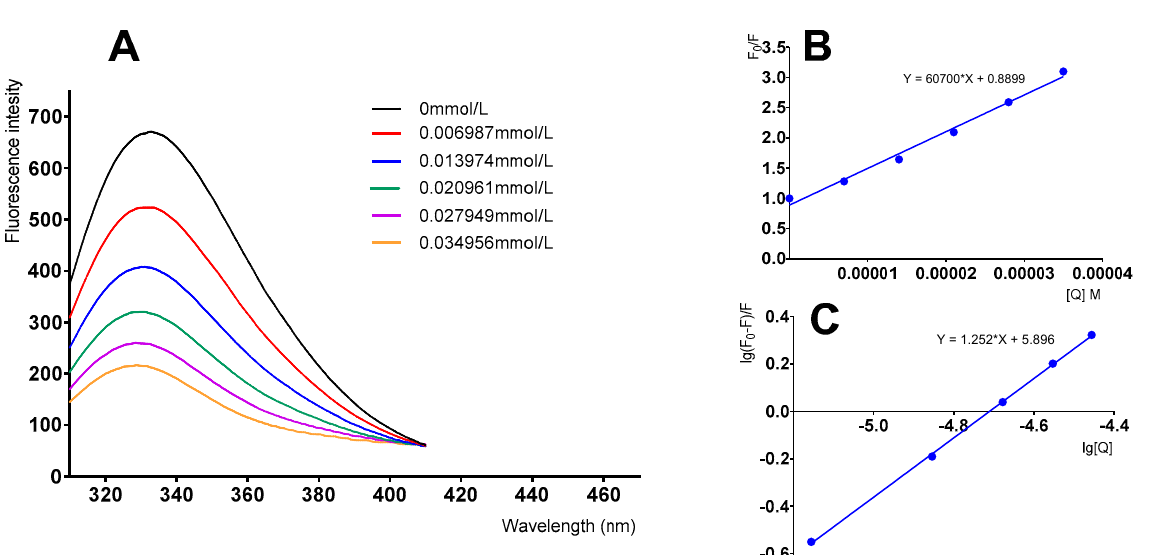
Figure 4. Fluorescence quenching studies of α -glucosidase by fisetin. ( A ) Fluorescence spectra of α -glucosidase in the presence of fisetin at different concentrations. ( B ) Stern-Volmer plots for α -glucosidase quenching by fisetin. ( C ) Plots of lg(F 0 − F)/F versus lg[Q] for the fisetin-glucosidase system.